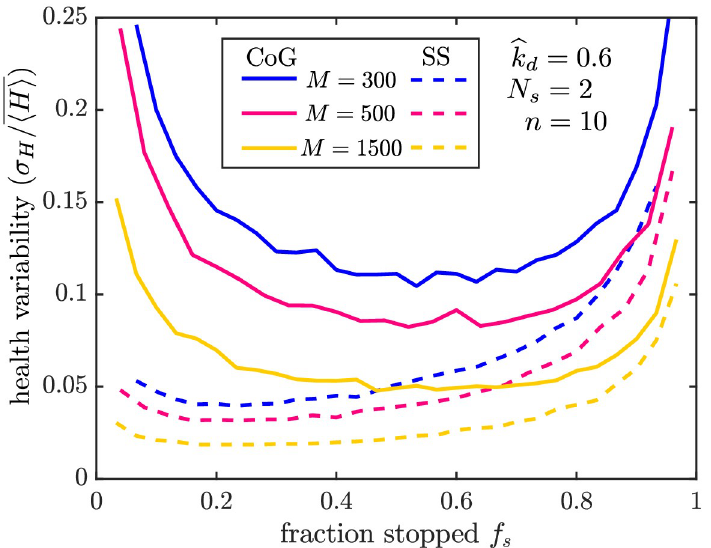
Fig 7. Variability of mitochondrial health in different maintenance models. Plotted is the standard deviation in ) divided by its average value ( h H i ), across 1000 iterations of stochastic simulations. Results are health per region ( σ H shown for 300 (blue), 500 (magenta), and 1500 (yellow) average mitochondria in the domain. Solid lines correspond to simulations of the CoG model and dashed lines to the SS model. All simulations used parameters ^ k N s = 2. Corresponding plots are provided in S3 Fig to show the effect of lower decay rates (S3 Fig) and of random stationary mitochondria distribution in the SS model (S3 Fig).